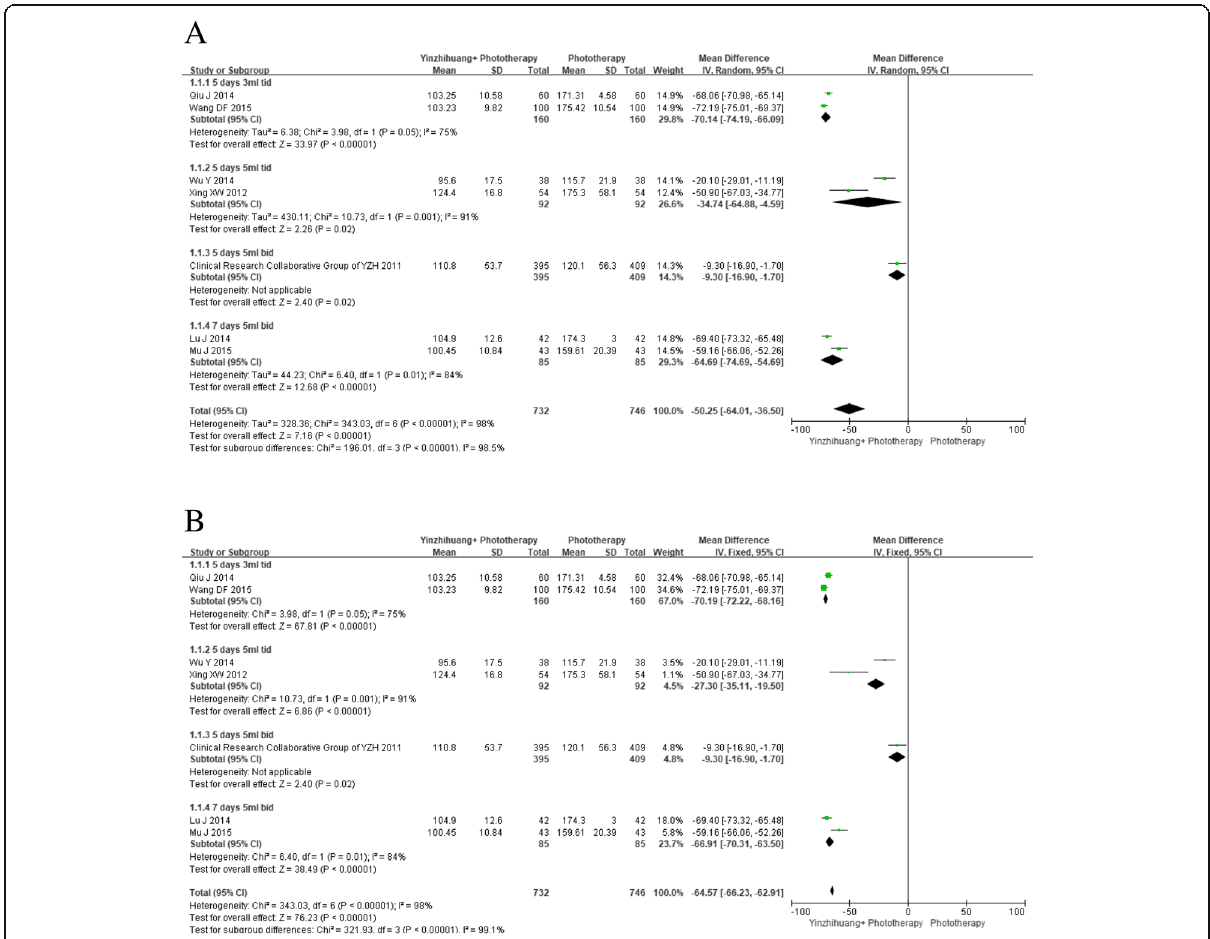
Fig. 3 a . Forest plot of total serum bilirubin ( μ mol/l) and subgroup analysis based on dosage of Yinzhihuang oral liquid (random effect model). b . Forest plot of total serum bilirubin ( μ mol/l) and subgroup analysis based on dosage of Yinzhihuang oral liquid (fixed effects